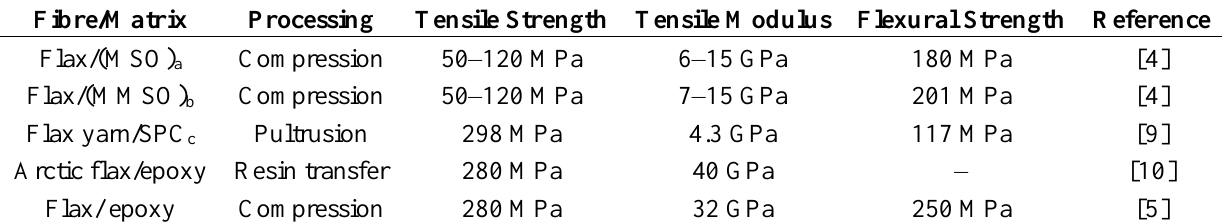
Table 1. Examples of mechanical properties of flax-thermoset